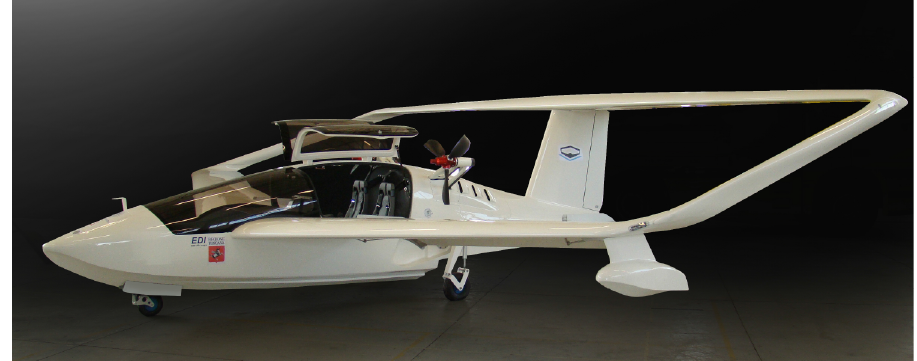
Fig. 1. An example of Prandtl Plane con fi guration developed during the IDINTOS project for a light amphibious